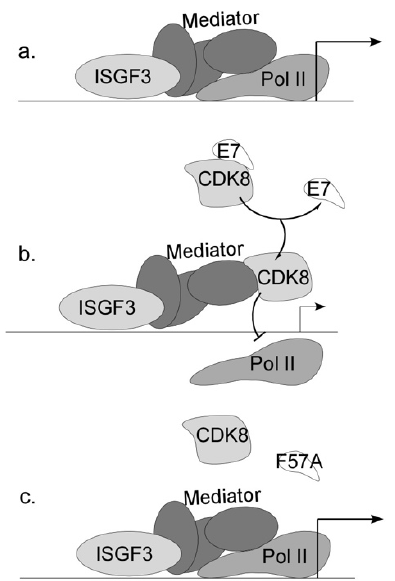
Figure 8. Model for the transcriptional suppression of ISGs by E7. ( a ) Factors necessary for transcription, such as Mediator and Pol II, are present at the promoters of ISGs in HFKs, and transcription occurs. ( b ) Wild type E7 associates with and recruits CDK8 to ISG promoters and this results in gene suppression, possibly due to loss of Pol II recruitment. ( c ) In cells containing F57A mutant E7, CDK8 is not efficiently recruited to ISG promoters due to reduced association between E7 F57A and CDK8. ISGs remain activated and expressed.